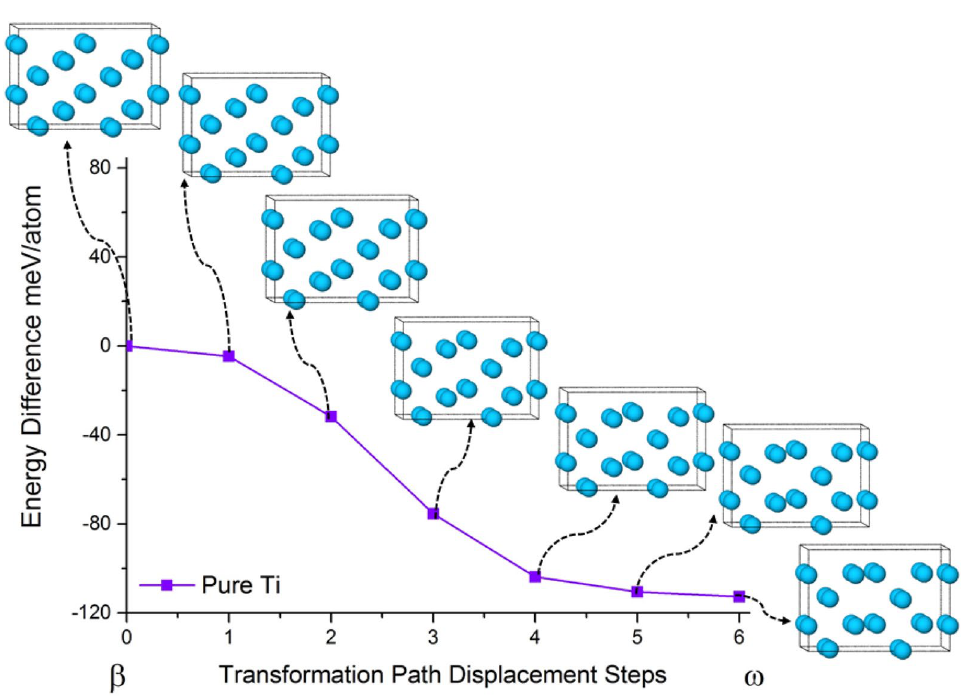
Figure 3. The intermediate images along the β → ω MEP in pure Ti and their energies are